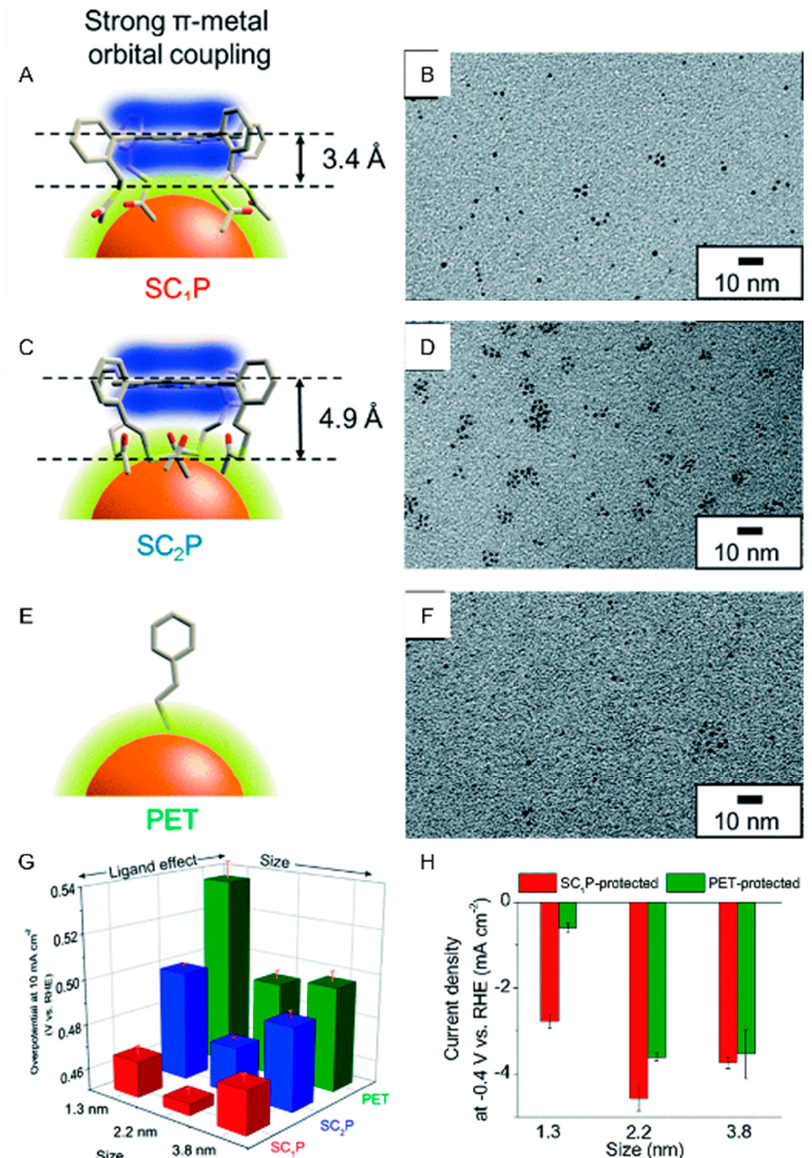
Figure 3. ( A , C , E ) Schematic illustration of coordination of ligands: ( A ) porphyrin SC 1 P, ( C ) porphyrin SC 2 P, and ( E ) PET. ( B , D , F ) TEM images of Au NCs with a core size of approximately 1.3 nm protected by porphyrin SC 1 P, porphyrin SC 2 P, or PET, respectively. ( G ) Comparison of overpotential at − 10 mA cm − 2 and ( H ) current density at − 0.4 V of each size of Au NCs protected with each ligand. Panels ( A – H ) are reproduced with permission from reference [107]. Copyright Royal Society of Chemistry, 2018.